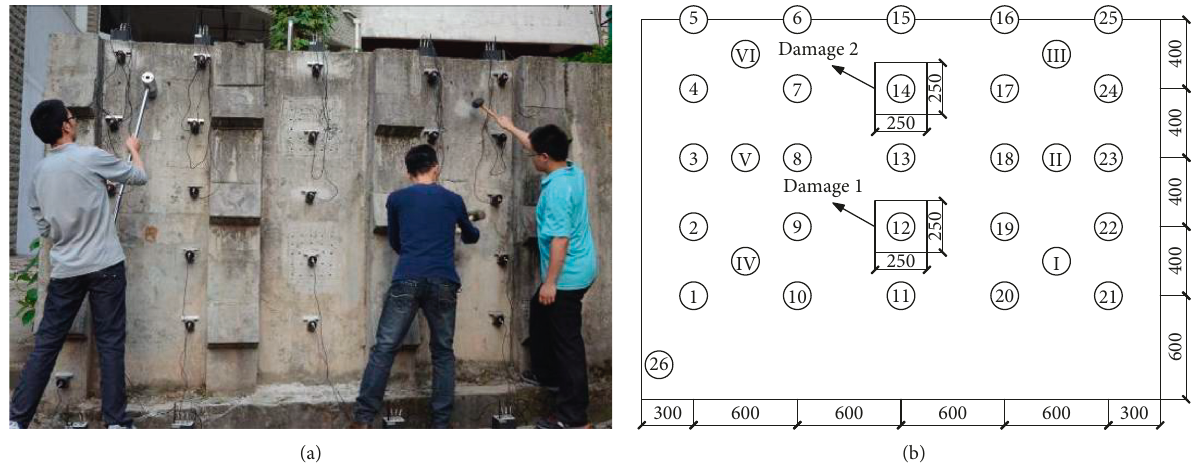
Figure 3: Pile plate retaining wall in model tests. (a) Vibration tests. (b) Assignment of sensors (unit: